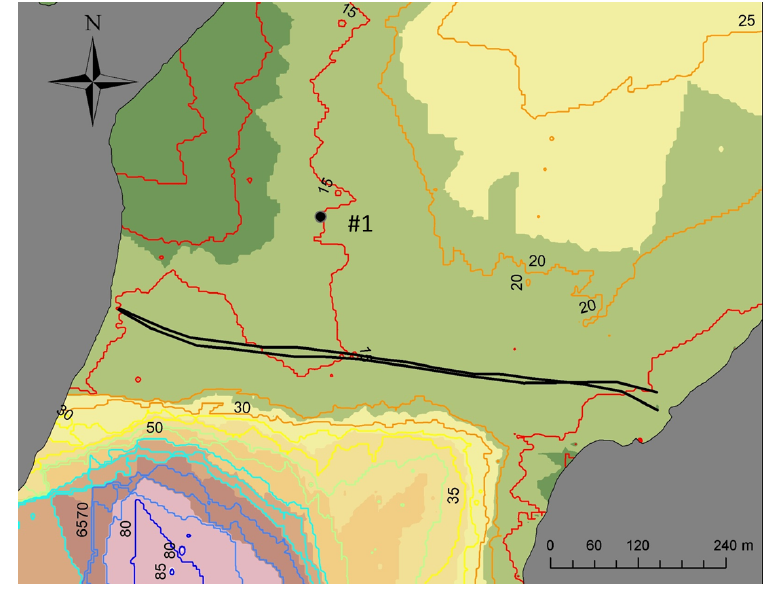
Figure 4. Bathymetry over Skarpsundet with the position of the bottom-mount measurement with the ADCP (# 1) and transect measurement (black lines) marked out.